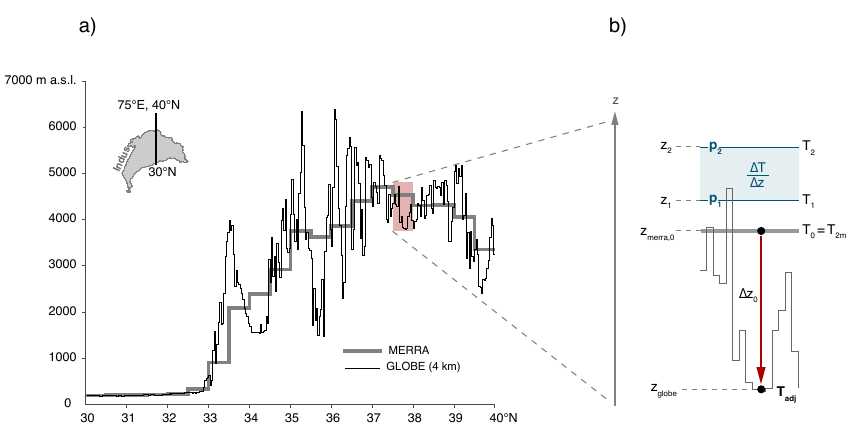
Figure 2. Procedure for elevation adjustment of MERRA temperature. (a) Comparison of MERRA and NOAA GLOBE (reduced to 4km resolution) topography along 75 ◦ E from 30 to 40 ◦ N. (b) Enlargement of the marked subsection in (a) , demonstrating the variables in Eq. (2). z globe is the height of the topography in GLOBE, z merra,0 that of MERRA and (cid:49)z 0 the difference between the two. z 1 is the height of the MERRA pressure level that is closest to the ground, and z 2 is the height of the next pressure level above this. T 0 is the 2m temperature in MERRA and T adj the final adjusted temperature. (cid:49)T/(cid:49)z is the vertical temperature gradient in the layer between z 1 and z 2 . This is combined with (cid:49)z 0 to adjust the MERRA temperature ( T 0 ) from the MERRA elevation to the NOAA GLOBE elevation ( T adj